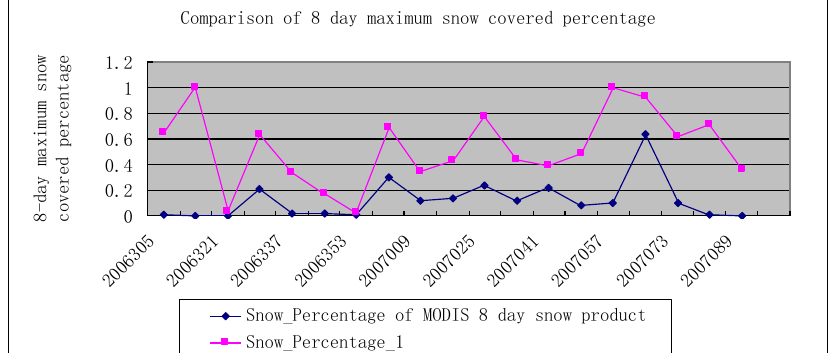
Comparison of 8 day maximum snow covered percentage